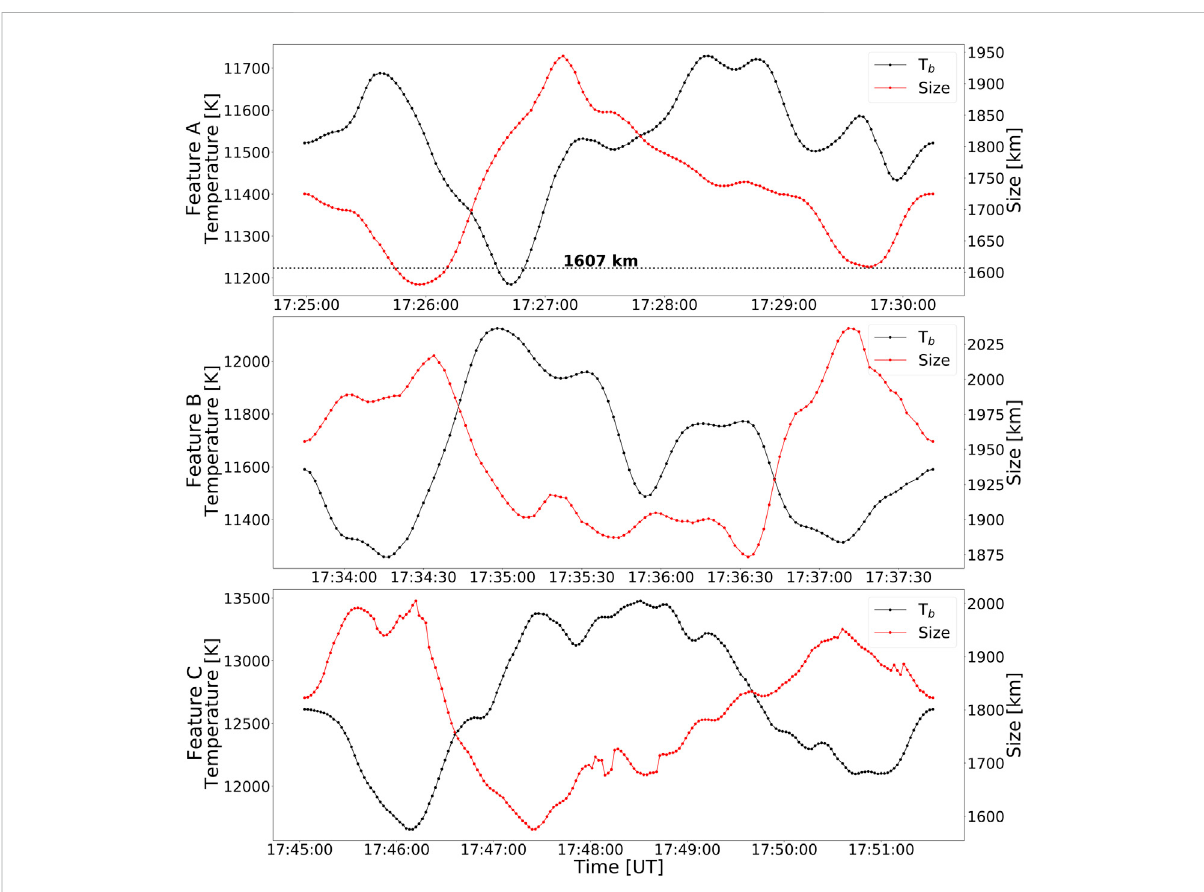
FIGURE 13 Temporal variations in brightness temperature (black, left axis) and size (red, right axis) of the three small bright features detected in a plage region. The horizontal dotted line marks the size of a spatial-resolution element. From Guevara Gómez et al.